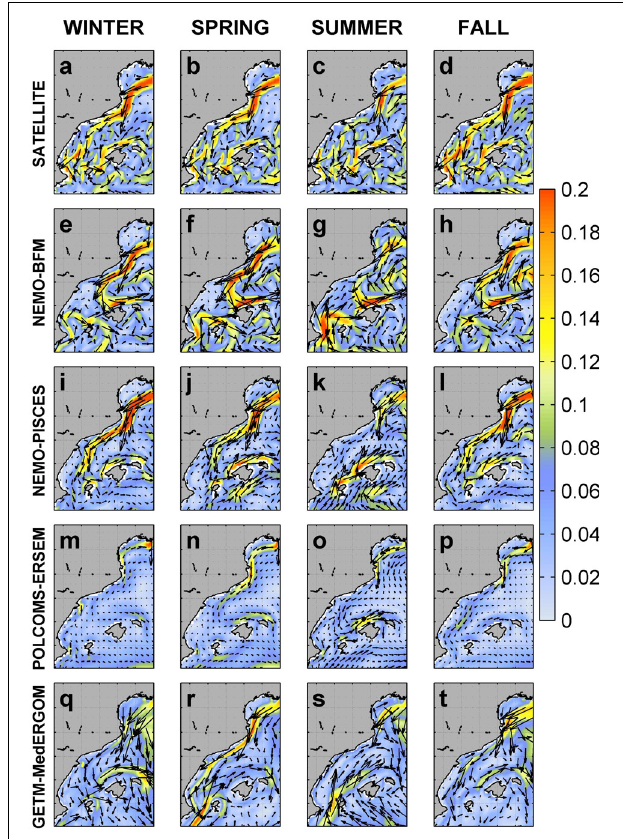
FIGURE 2 | Seasonal pattern of surface currents derived from satellite and the four runs. Intensity (m s - 1 ) and circulation patterns are shown. Satellite (a–d) , NEMO-BFM (e–h) , NEMO-PISCES (i–l) , POLCOMS-ERSEM (m–p) , and GETM-MedERGOM (q–t)